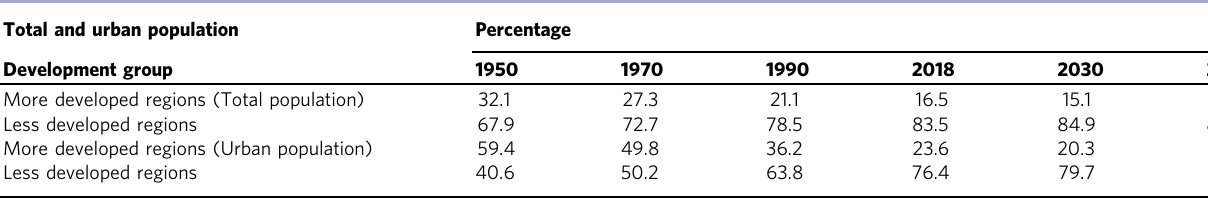
Table 1 Population and urbanization per cent in developed and less developed regions (1950 – 2050).